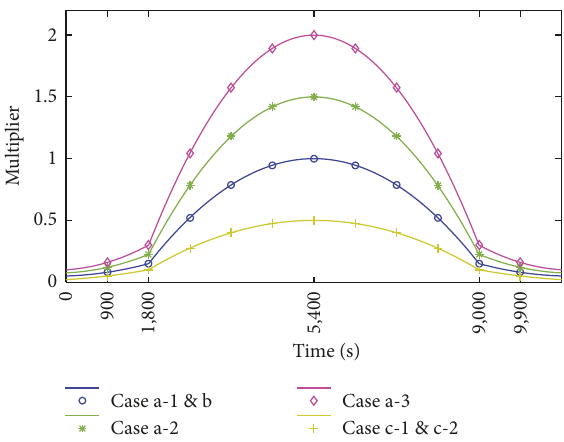
Figure 10: Passenger demand patterns in different cases.